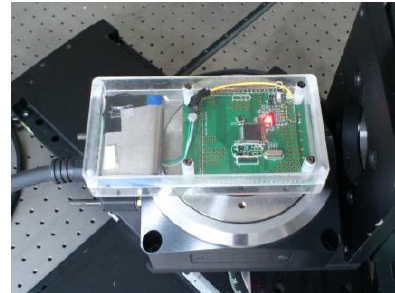
Figure 3. Six-axis translation and rotation platform